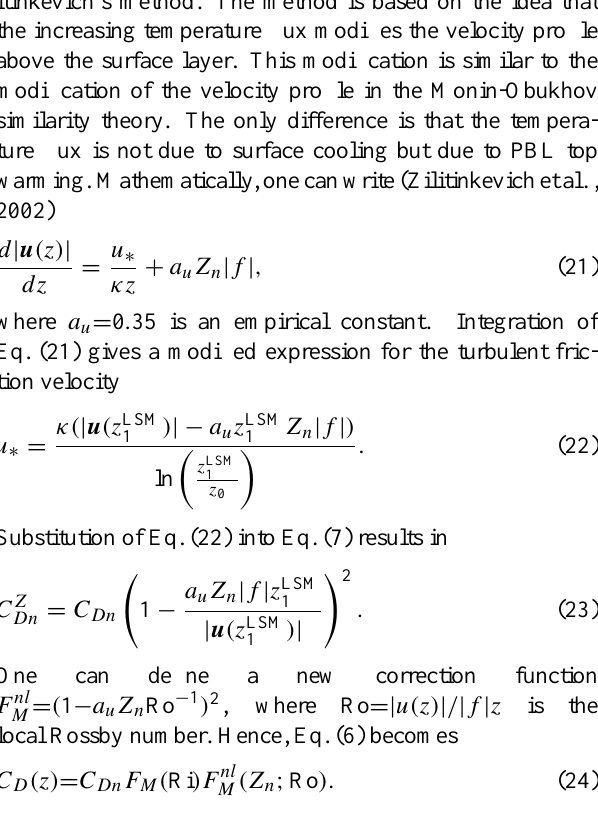
Fig. 10. The dependence of C LES is given by Eq. (20). Symbols and lines are the same as in Fig. 5.